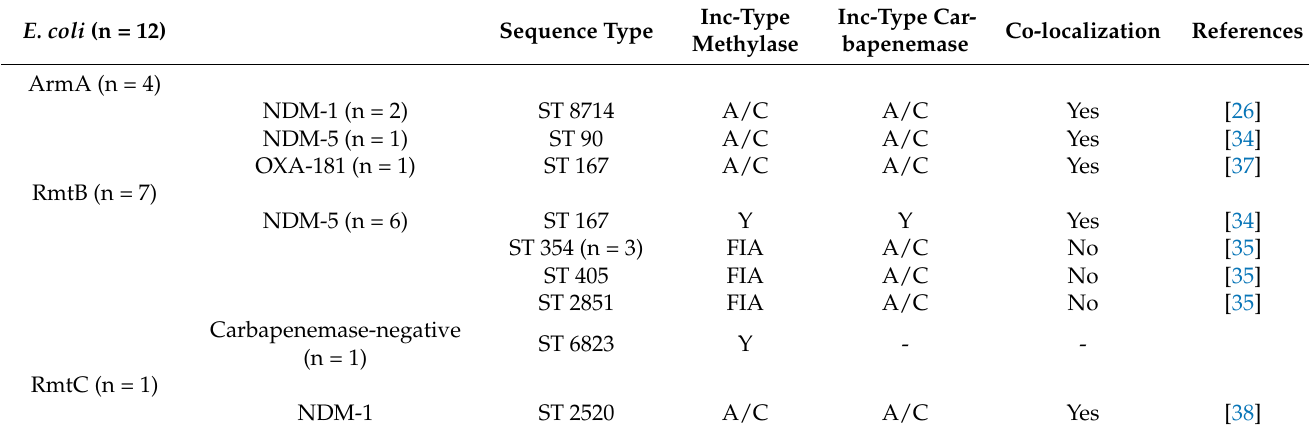
Table 4. Association of 16S RMTases, carbapenemases, sequence types, and plasmid incompatibility groups among pan-aminoglycoside- and carbapenem-resistant E. coli